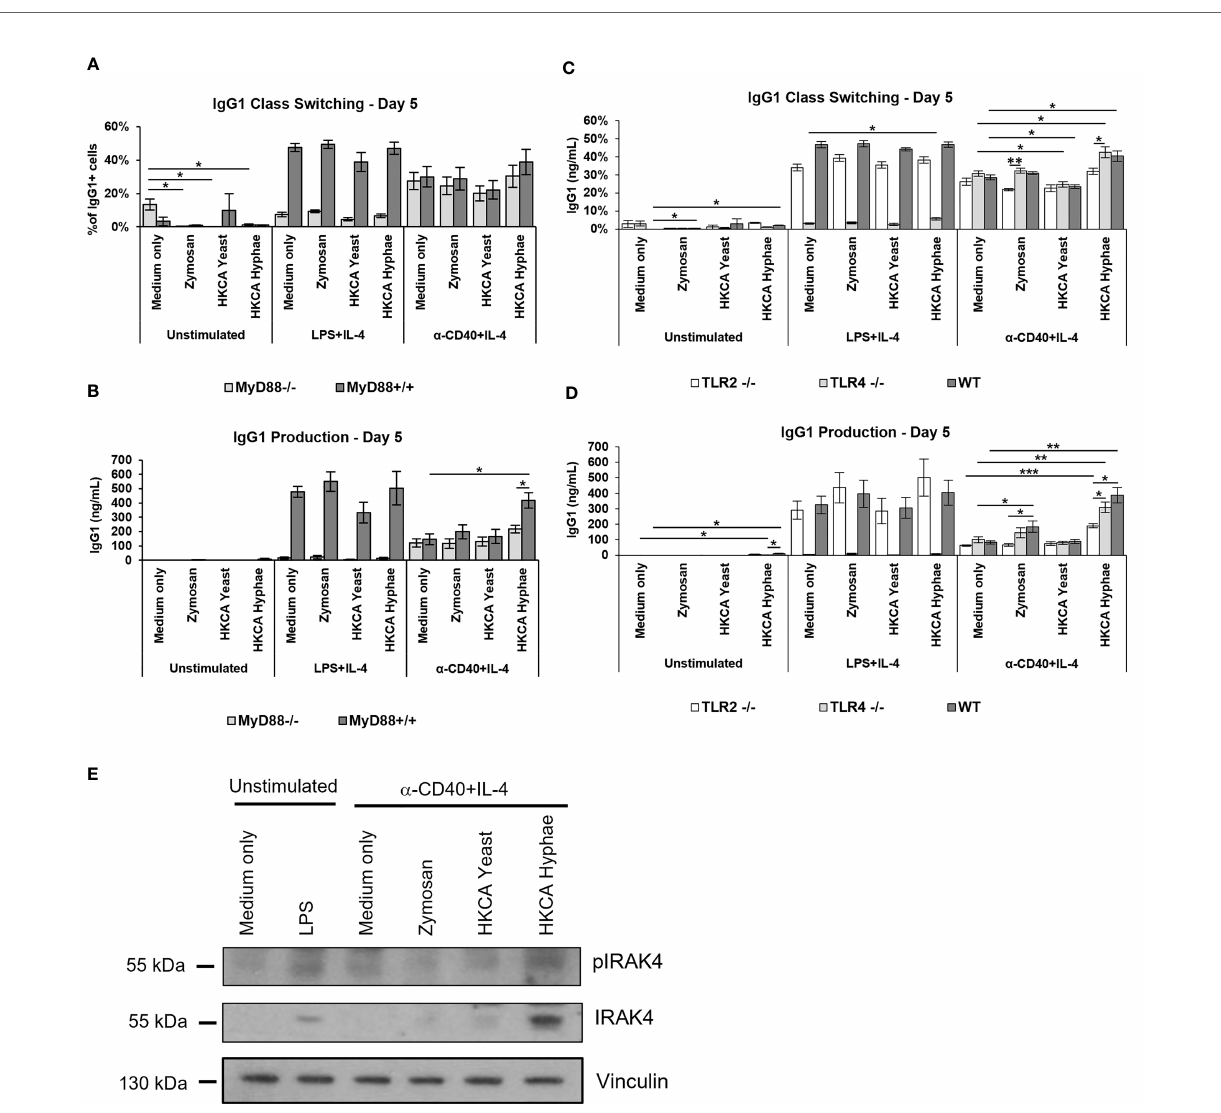
FIGURE 4 | Increased antibody production upon stimulation with Zymosan or HKCA hyphae is mostly mediated via TLR2 recognition in an MyD88-dependent manner. Splenic B cells from MyD88 -/- and MyD88 +/+ mice (A, B) and TLR2 -/- , TLR4 -/- and wildtype (WT) control mice (C, D) were cultured unstimulated or stimulated with LPS +IL-4 or anti-CD40+IL-4 in the presence of Zymosan, HKCA yeast or HKCA hyphae. After 5 days of culture, the percentage of IgG1-positive cells within live B cells was measured by fl ow cytometry (A, C) , and the concentration of secreted IgG1 was measured by ELISA (B, D) . Data represent mean ± SEM of 4 mice per genotype, with triplicate measurements performed for each mouse. Since cells lacking MyD88 and TLR4 expression cannot recognize LPS, in cells stimulated with LPS+IL-4 the difference between MyD88-/- or TLR4 -/- and WT cells is statistically signi fi cant for all samples. (E) Western Blot analysis for the expression of phosphorylated IRAK4 (pIRAK), IRAK4 and vinculin in B cell lysates after 12 hours of stimulation. *p < 0.05, **p < 0.005, ***p <